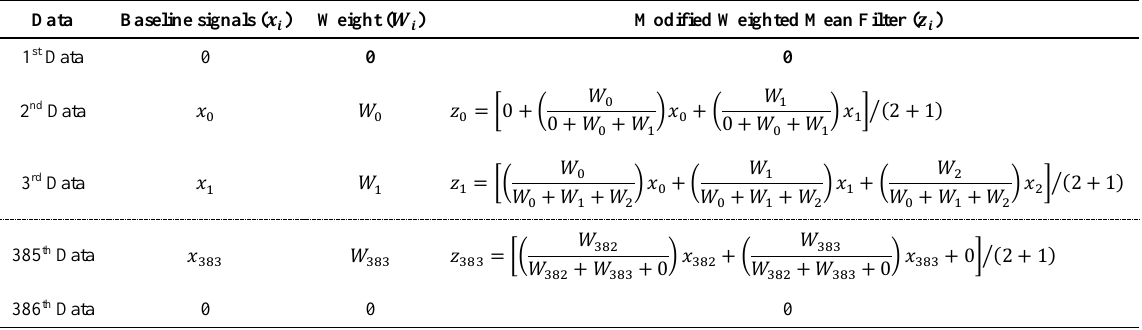
Table 3. Illustration of the smoothing process in the baseline EEG